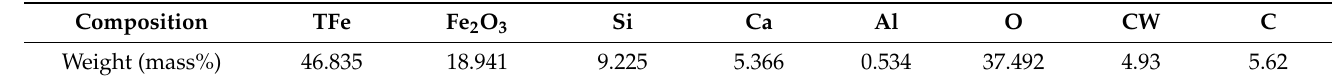
Table 1. Composition of original iron ore.